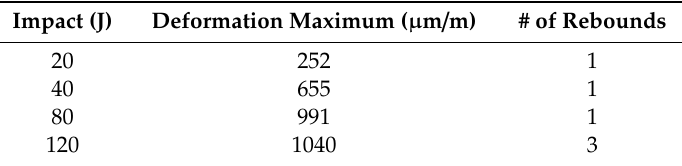
Table 4. Conditions of the vertical weight drop tests on panels modified with viscoelastic layer.